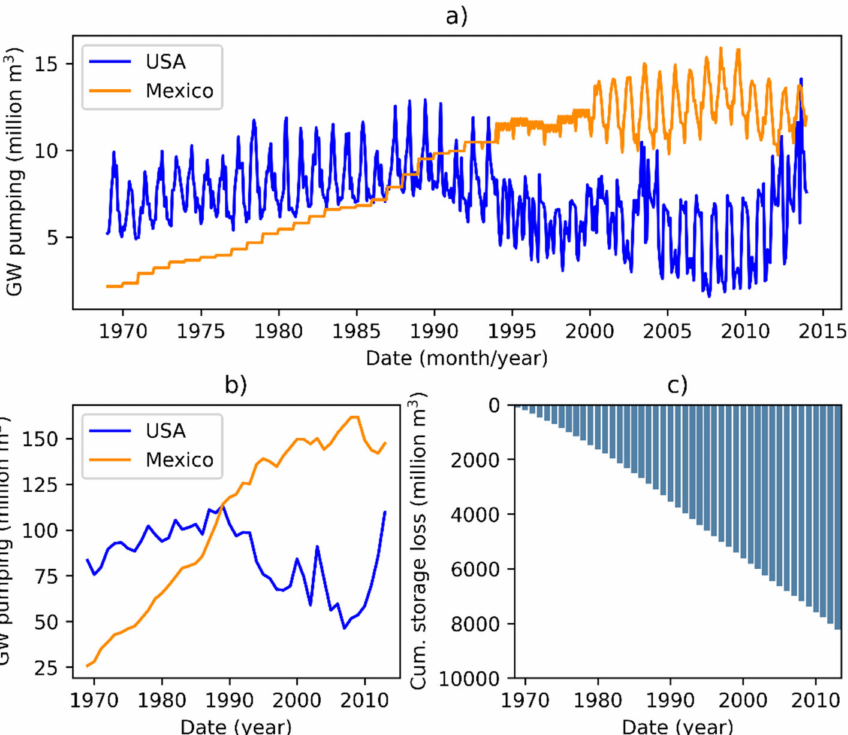
Figure 2. ( a ) Temporal variation in monthly total groundwater (GW) pumping in USA (average value of 346 wells) and Mexico (average value of 266 wells); ( b ) yearly variation of GW pumping in USA and Mexico. Daily data from these wells were used to compute monthly and annual total GW pumping; and ( c ) cumulative storage loss from the aquifer with respect to the initial year taken in this study (1969). Note: bars are inverted here to represent storage